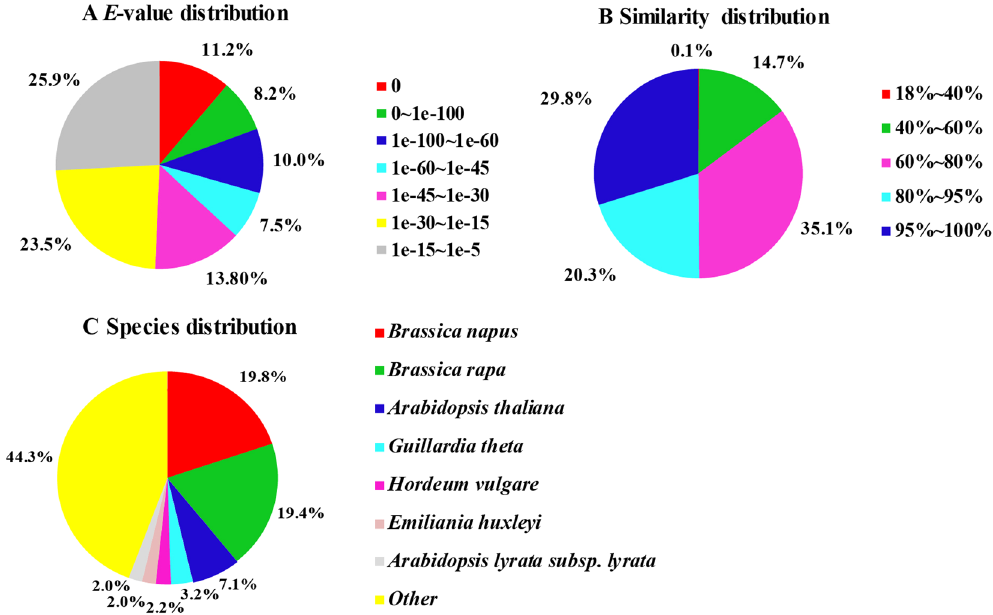
Figure 2. Characteristics of sequence homology of pak choi root BLAST against NCBI non-redundant (NR) database. ( A ) E -value distribution of BLAST hits for matched unigene sequences, using an E -value cutoff of 10 − 5 . ( B ) Similarity distribution of top BLAST hits for each unigene. ( C ) Species distribution of the top BLAST